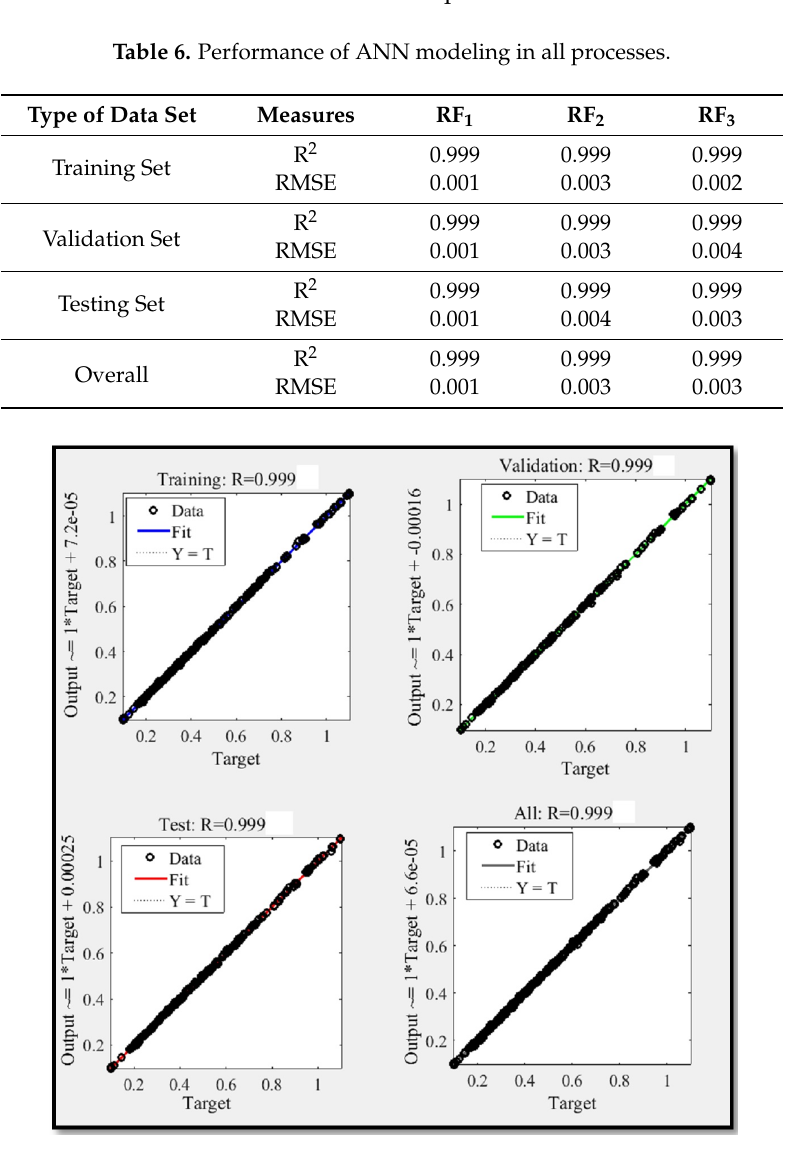
Figure 7. Correlation of the overall processes (training, validating, and testing) for the recovery factor.